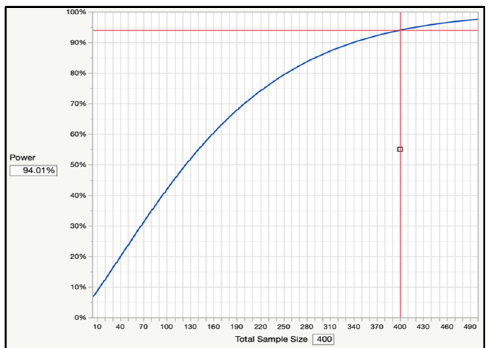
Figure 1. Power Analysis for Sample Size